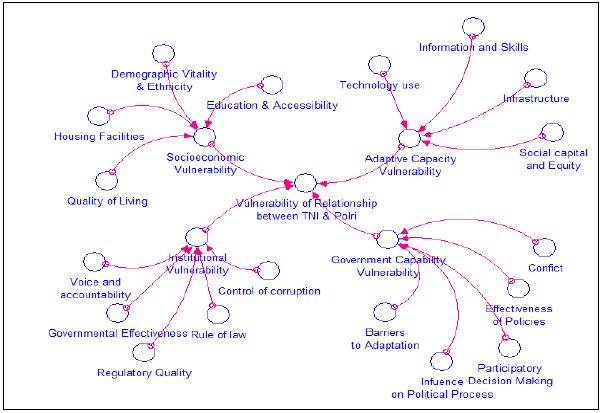
Fig. 3. Causal Loop Diagram on the vulnerability of the TNI-Polri Relations